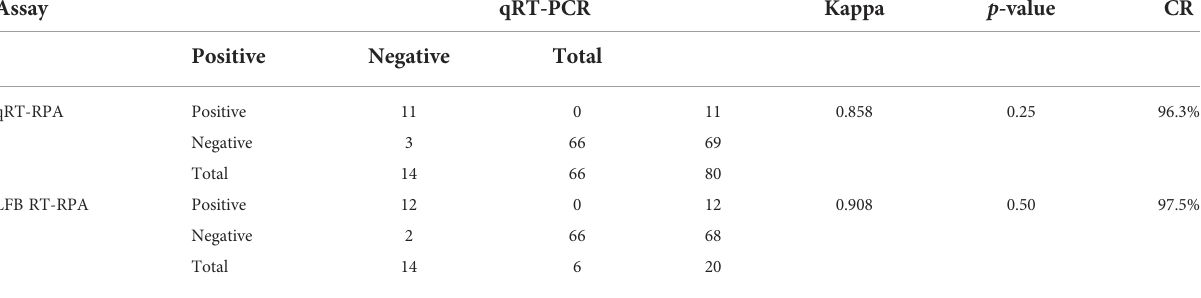
TABLE 3 Comparative performances of the qRT-PCR, qRT-RPA, and LFB RT-RPA assays for the detection of HEV RNA in raw pork livers. Assay